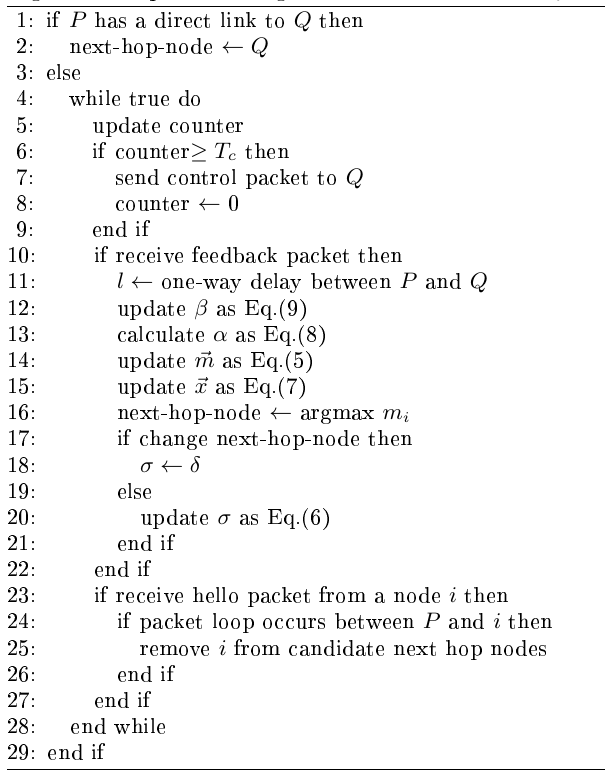
Algorithm 1 update routing table on node. P to node.